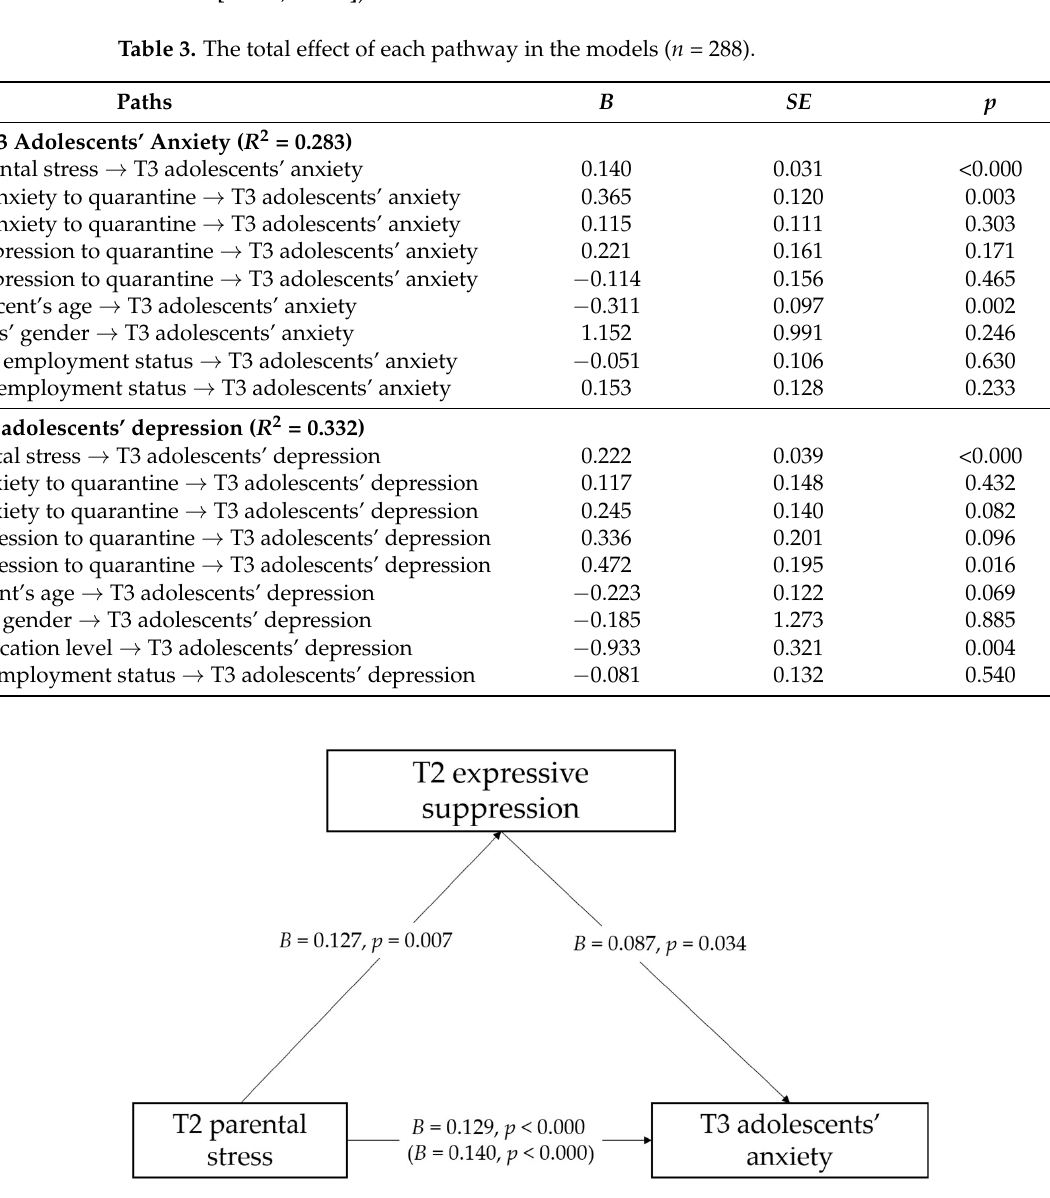
Figure 1. The mediation role of T2 expressive suppression in the association between T2 parental stress and T3 adolescents’ anxiety. Note: The sociodemographic variables and adolescents’ anxiety and depression symptoms to quarantine at T1 and T2 on the mediator and outcome are controlled for but are not shown for simplicity. Slope coefficients are unstandardized. Values in brackets refer to the total effect of T2 parental stress on T3 adolescents’ anxiety without including the mediator. Table 4. The specific direct and indirect effects for each pathway in the models ( n = 288). Paths